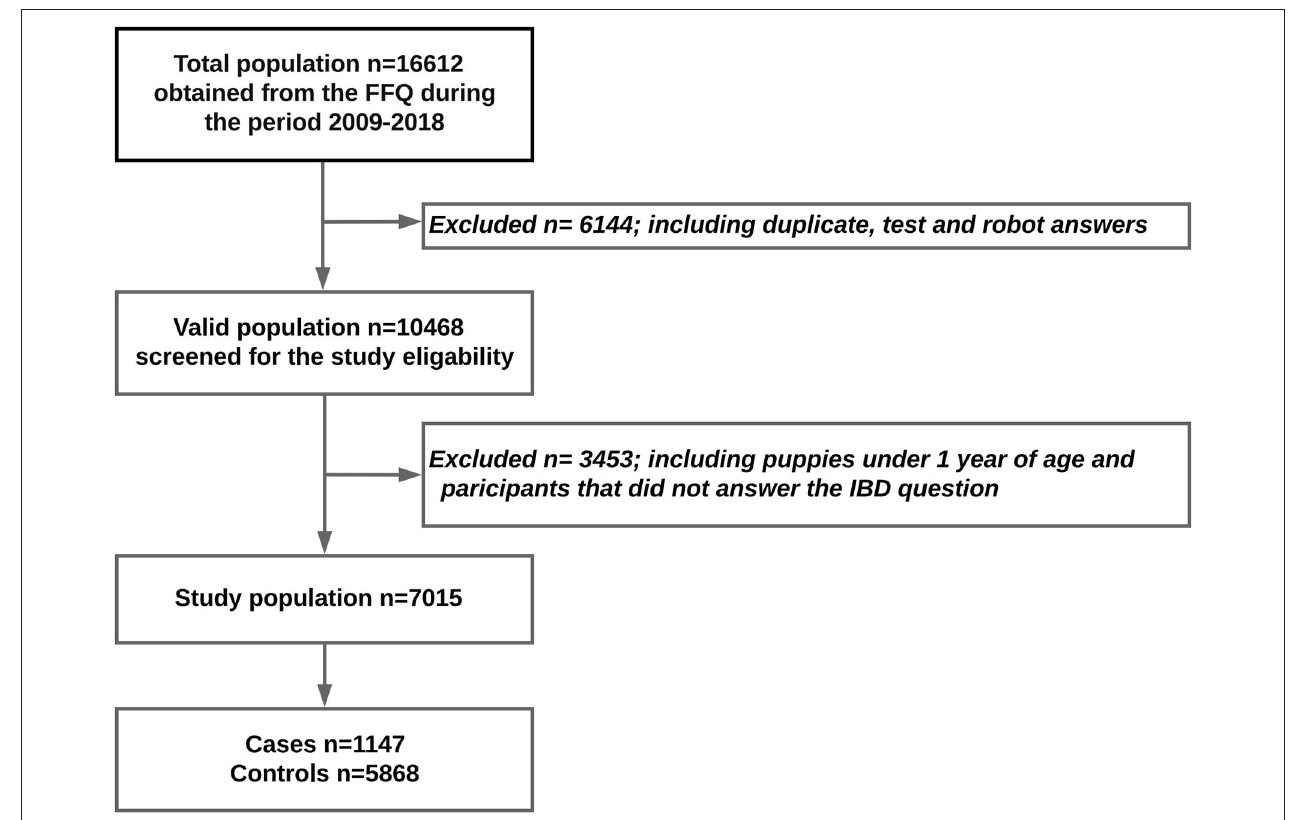
FIGURE 1 | Flow chart of the study